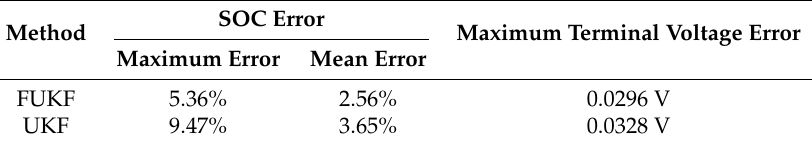
Table 1. Static discharge experiment result comparison.